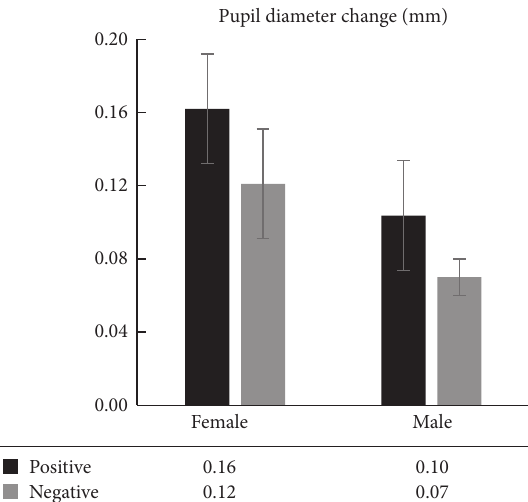
Figure 2: Comparison of the reaction time of emotional working memory between male and female patients with depression.